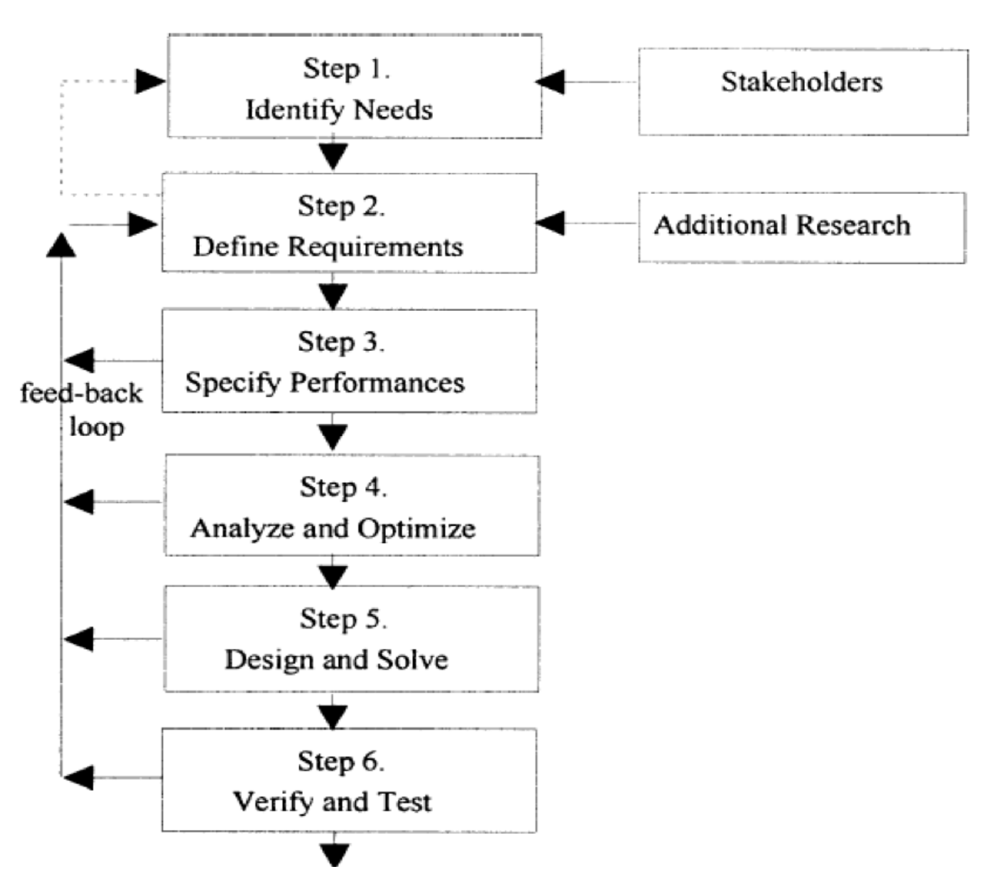
Figure 1. The systems engineering six steps method [47].